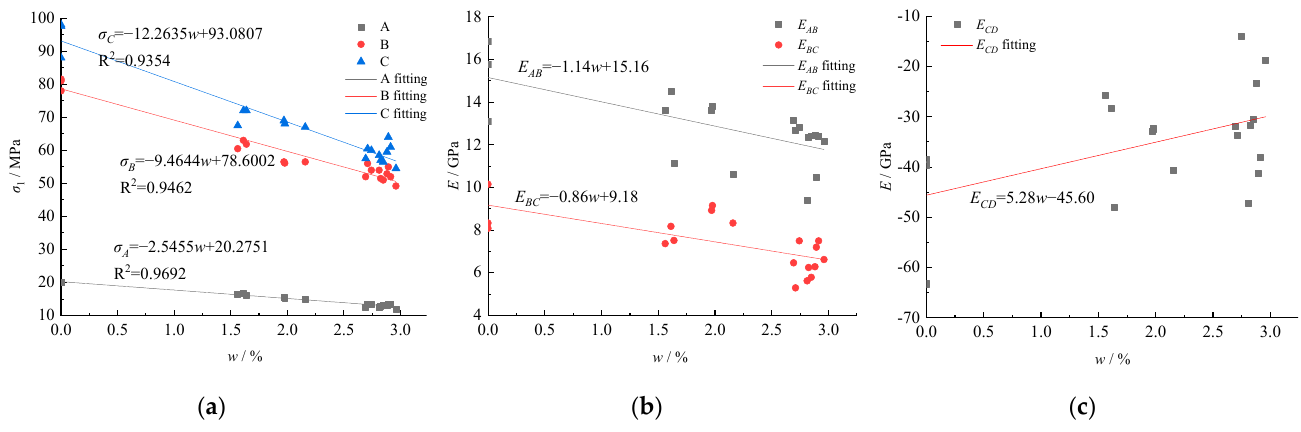
Figure 7. The mechanical turning points of the specimen under uniaxial compression, and the strength variance rate corresponding to the water content. ( a ) Mechanical turning point. ( b ) Stage AB and BC. ( c ) Stage CD.